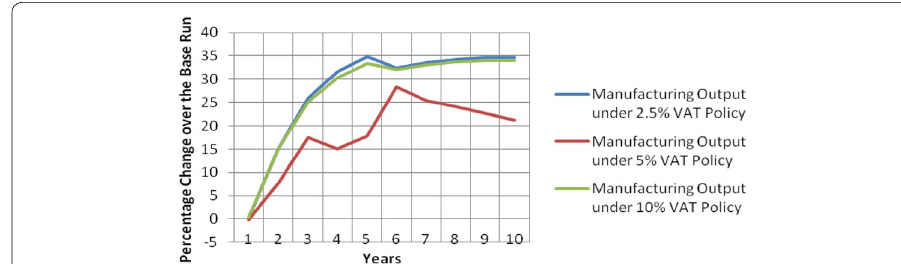
Fig. 19 Impact of different VAT policies on manufacturing output